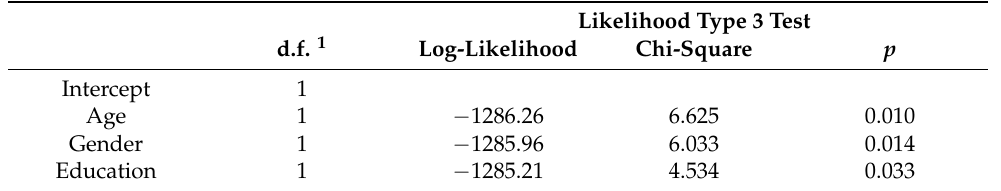
Table 2. Results of the regression model—residents, PV plants.